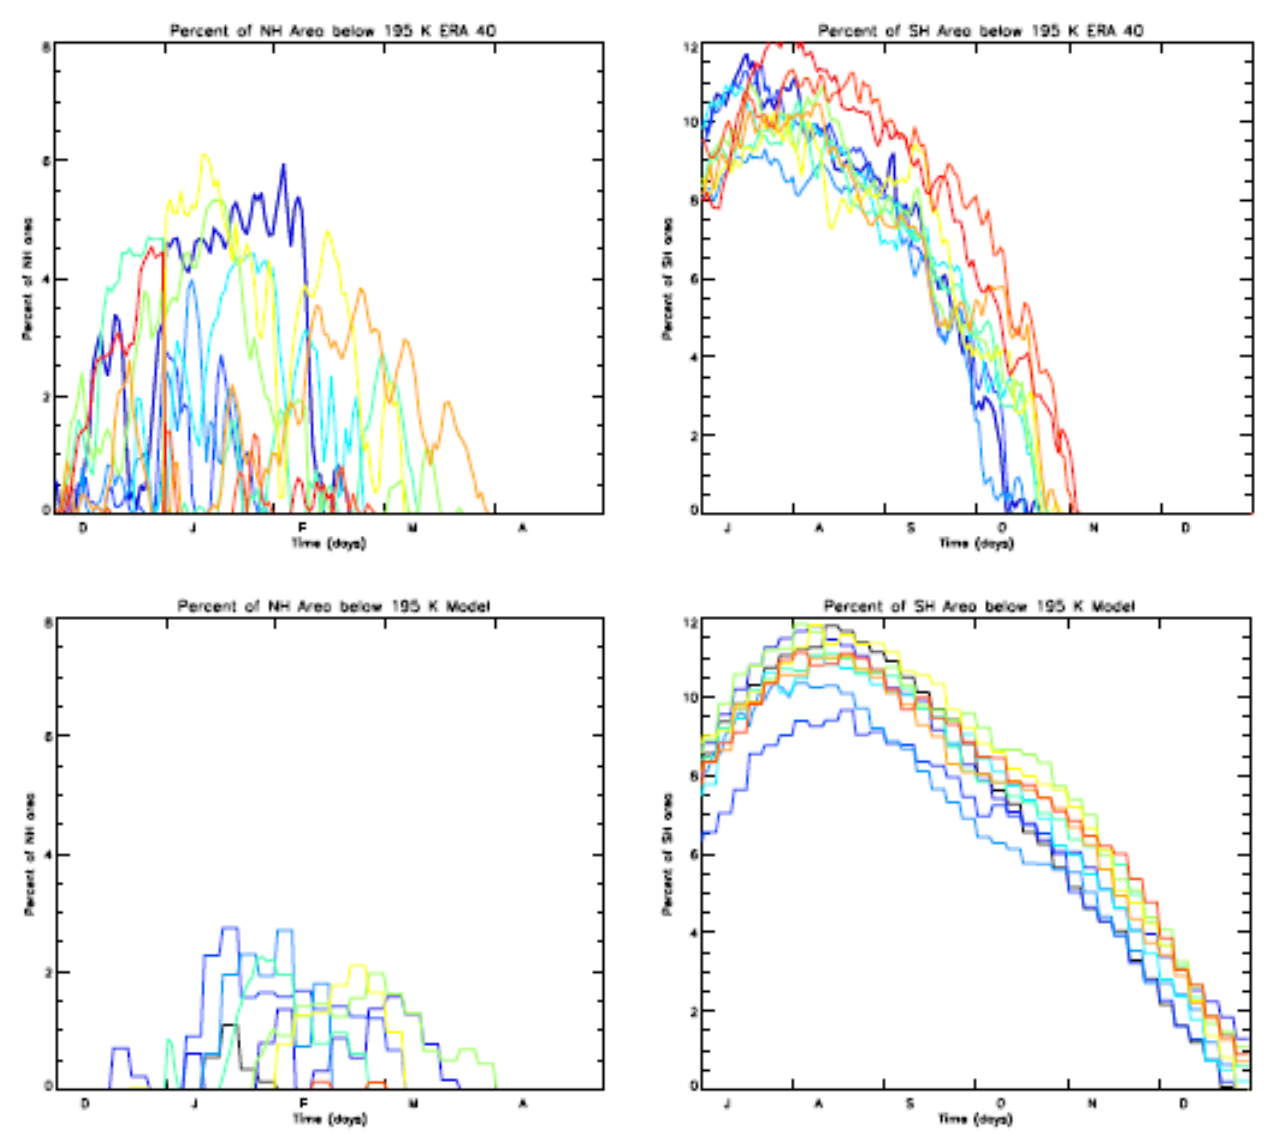
Fig. 13. Fractions of the Northern Hemisphere area (right) and of the Southern Hemisphere (left) covered by PSCs (with temperature below 195K) at 50hPa calculated by ERA 40 (top) and simulated by the model (bottom) for the period